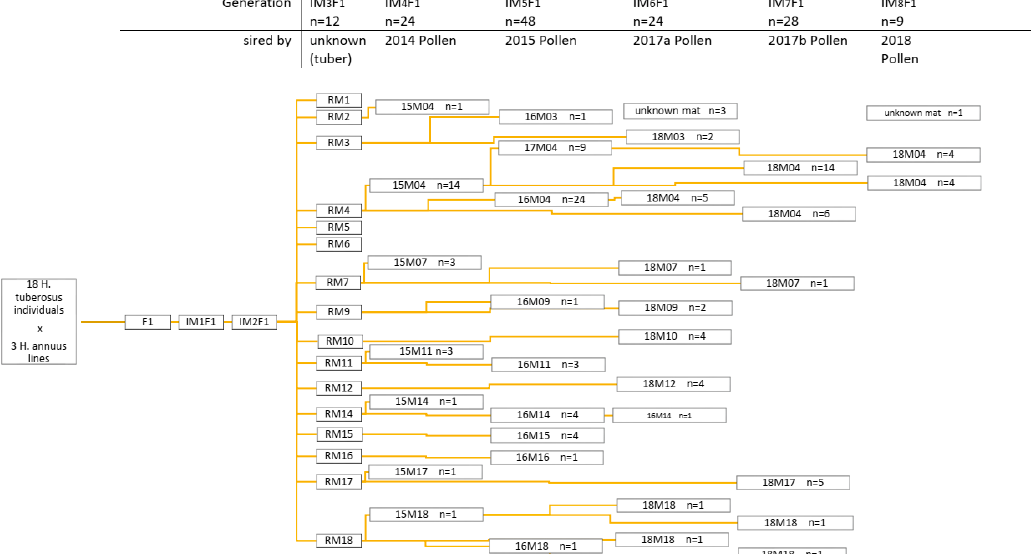
were designated random mated (RM) as all previous selected lines were grown in the same field and pollen control was not used. Downstream progeny is given pooled identifiers here based on the year they were produced, the breeder’s ID, and their maternal line. Each pooled ID is connected to its maternal ID (individual or pooled) by yellow lines and situated under the corresponding pollen donor cohort. Sample sizes are provided for each pooled ID. We note the four individuals with unknown maternity (i.e., seeds that escaped their individual envelope during